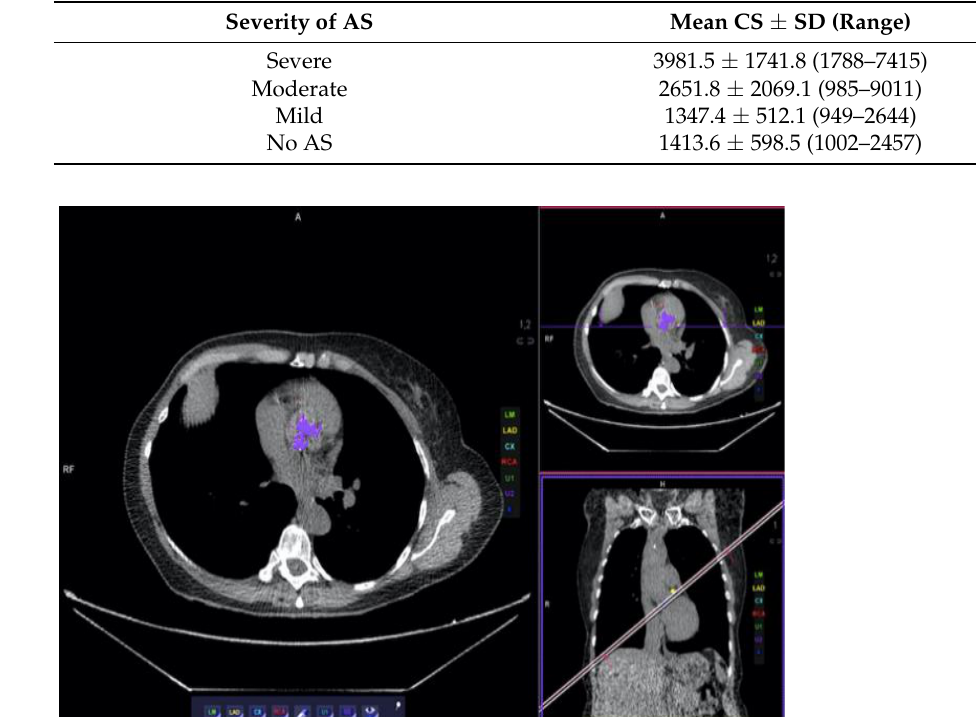
Table 2. The results of CS. CS—calcium score, AS—aortic stenosis.